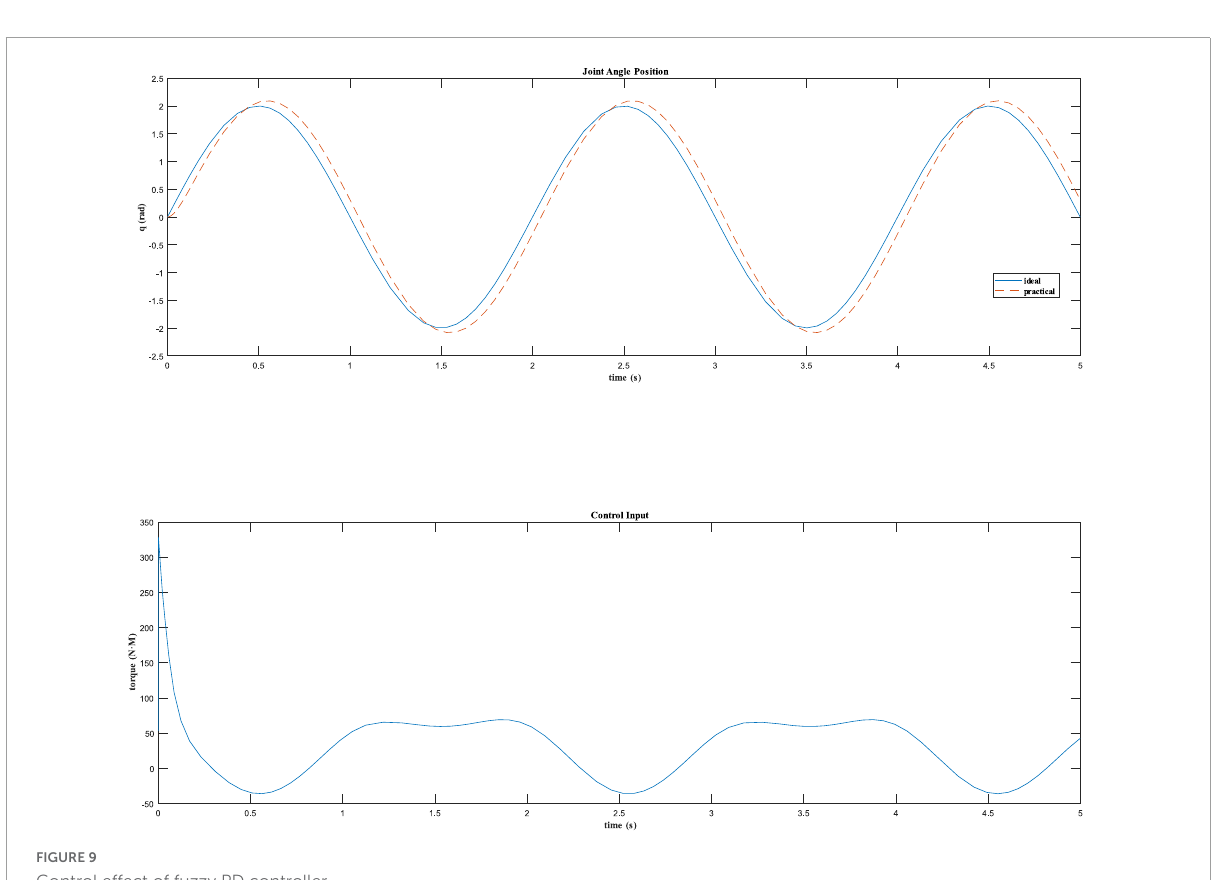
FIGURE9 Control effect of fuzzy PD